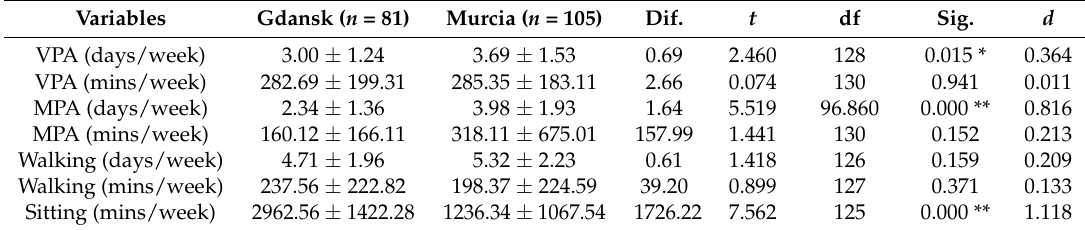
Table 3. Comparison of physical activity of males from Gdansk and Murcia.